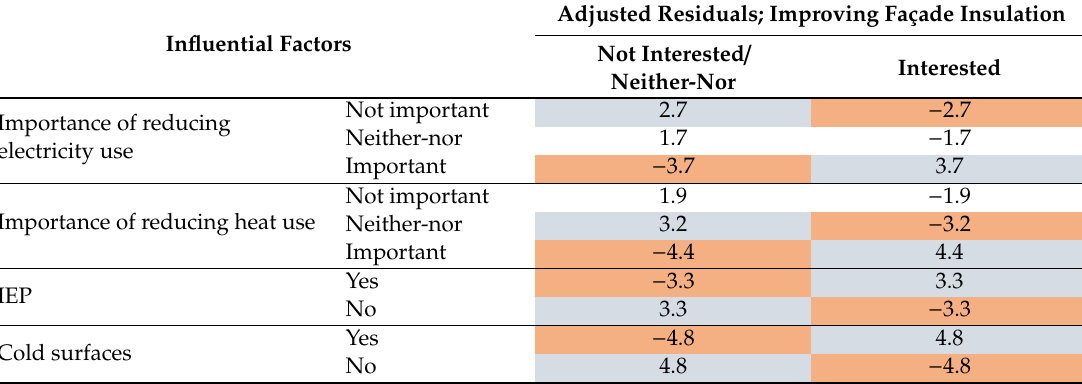
Table A4. Post-hoc analyses of influential factors on homeowners’ interest to improve facade insulation.